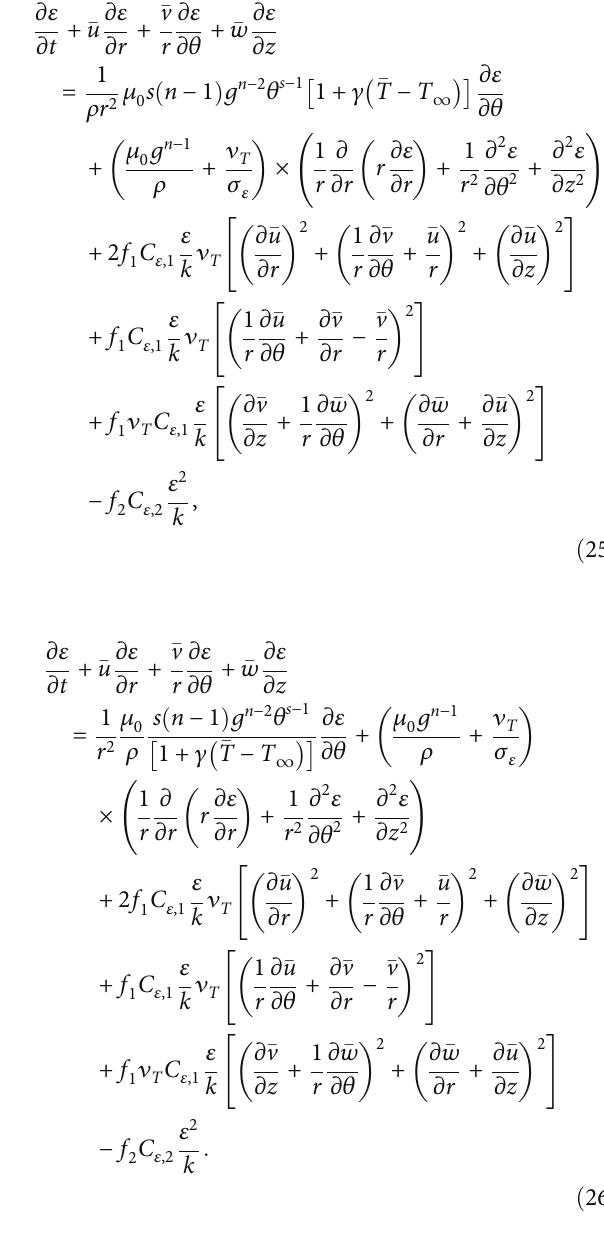
Equations (25) and (26) represent viscous dissipation equations for the gaseous and liquid phases respectively.